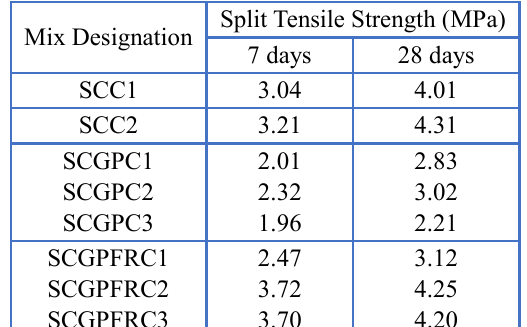
Fig. 9. spilt tensile strength testing machine. Split tensile strength values for all